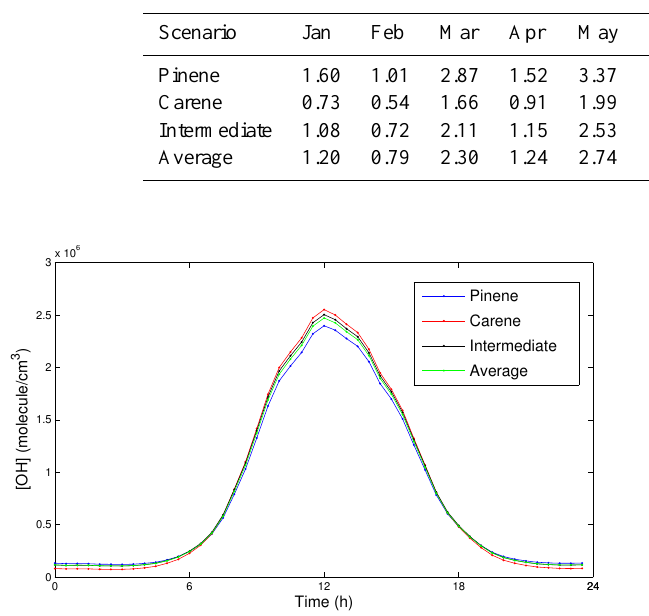
Figure 3. Average modelled (MEGAN 2.04) diurnal profiles of OH concentration at 14m for the summer of the year 2007 for the four chemotype scenarios (see Tables 1 and 2).